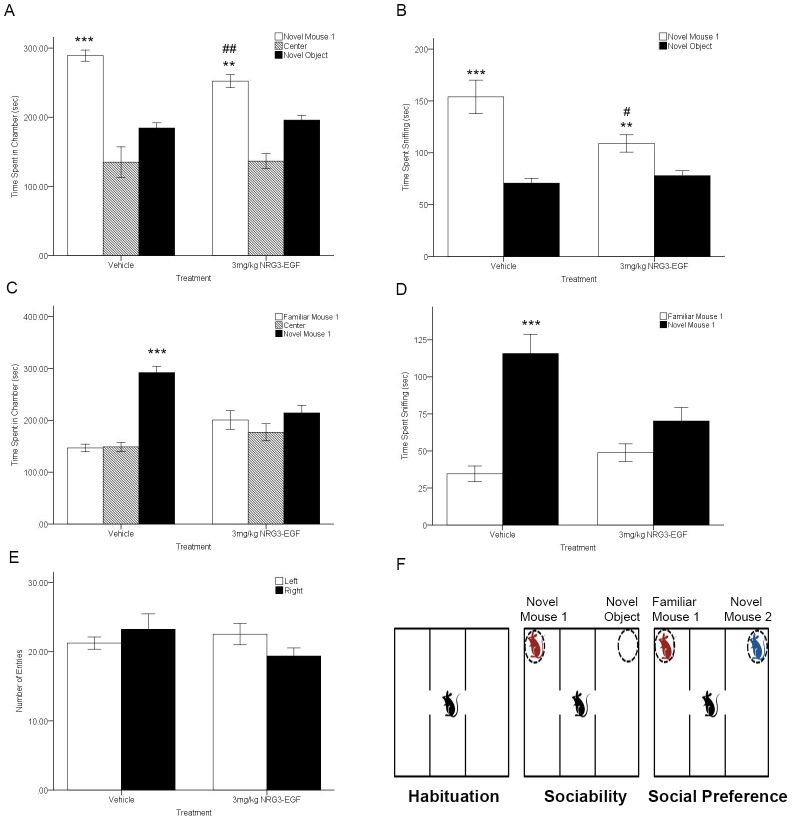
Neonatal overexposure to NRG3 impairs social behaviors in adulthood.(A) Vehicle and NRG3-EGF treated mice spent more time in chamber with the novel mouse 1 than a novel object in the 3-chamber test of sociability. (B) Both treatment groups showed preference for the novel mouse 1 in time spent sniffing; however, the preference was blunted in mice overexposed to NRG3-EGF compared to vehicle treated mice. (C) NRG3-EGF treated mice showed absence of preference for social novelty, spending equal time in the chamber with familiar mouse 1 and novel mouse 2. (D) Sniff time at familiar mouse 1 and novel mouse 2 was comparable in NRG3-EGF overexposed mice, whereas vehicle treated mice showed a significant preference for the more unfamiliar novel mouse 2. (E) During the initial 10-minute habituation period to the apparatus the number of entries was equal between right and left chambers. (F) Schematic showing the setup of the trials in the three-chambered social test apparatus. n = 11–12/treatment group. Data represents mean ± s.e.m. **p<0.01, ***p<0.001 within group comparison (novel mouse 1 vs. novel object or familiar mouse 1 vs. novel mouse 2), #p<0.05,##p<0.01 between group comparison (Vehicle vs. NRG3-EGF treated mice).